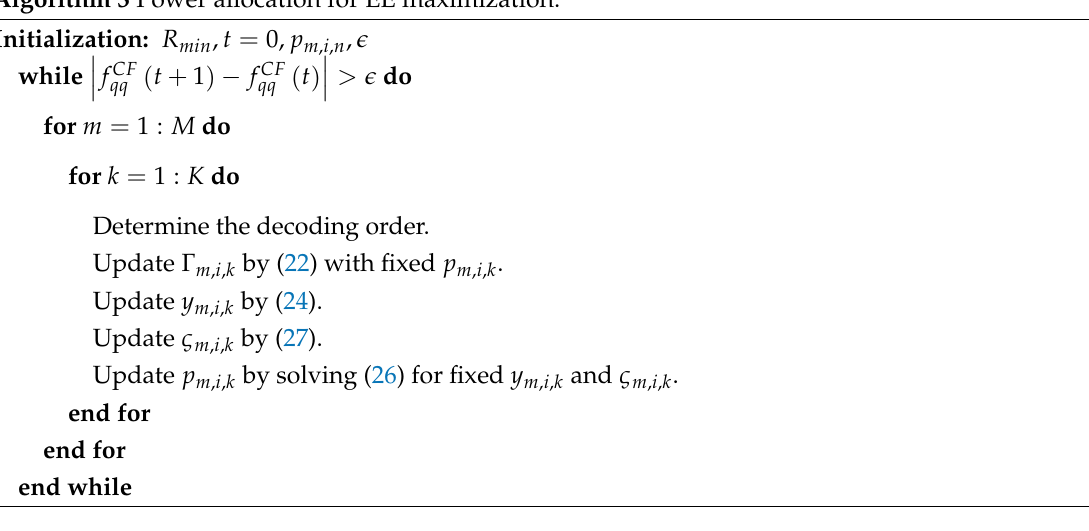
(cid:16) (cid:16) (cid:17)(cid:17) 1 / log , where (cid:101) is an error tolerance (see Table 2). (cid:101)